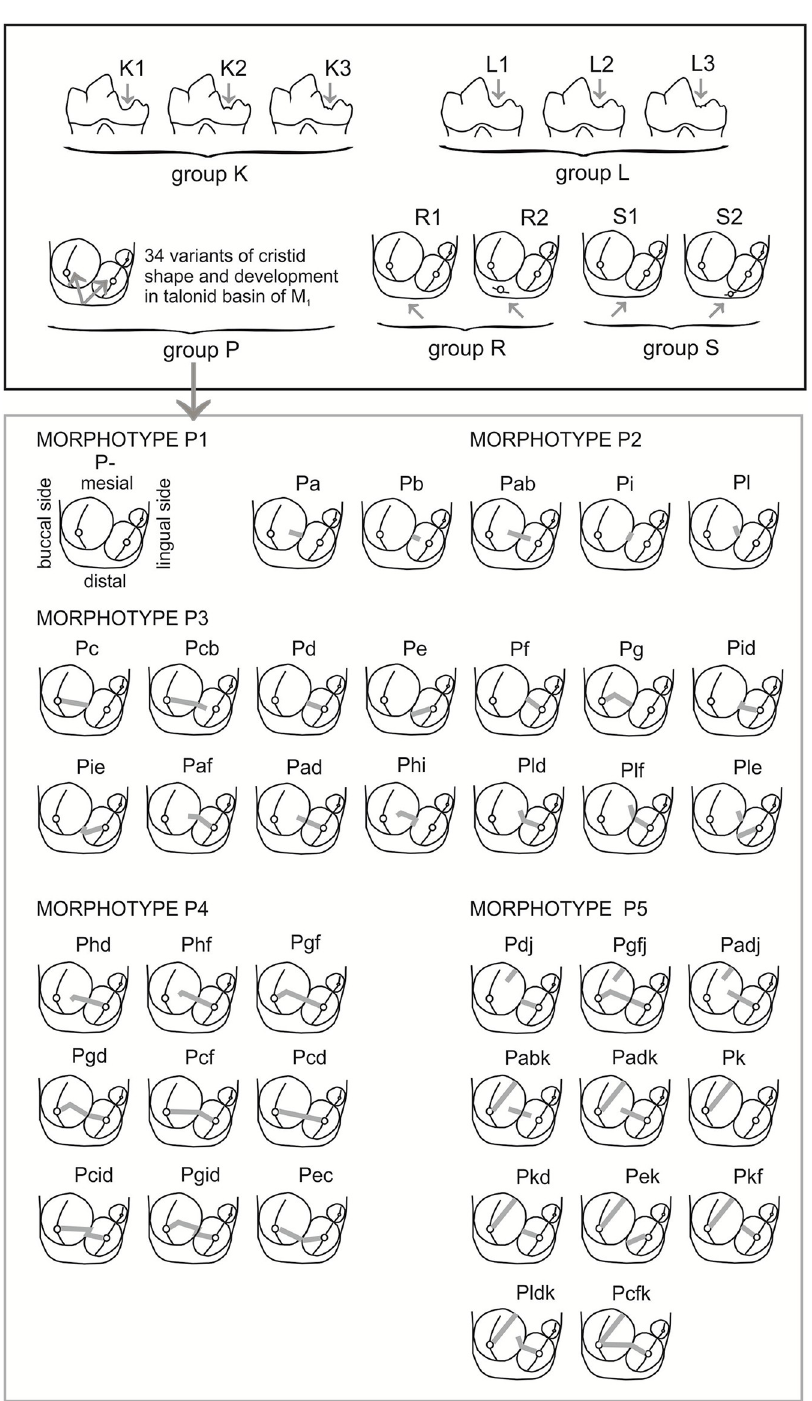
Fig 2. Graphic depiction of morphological variation of the first lower molar (M 1 ) in the red and arctic foxes. Group K–M 1 in lateral view, lingual side; group L–M 1 in lateral view, buccal side; group P, R, S–distal part of M 1 (talonid) in occlusal view. Definitions of the morphotypes, and morphotype variants are listed in S4 Table.